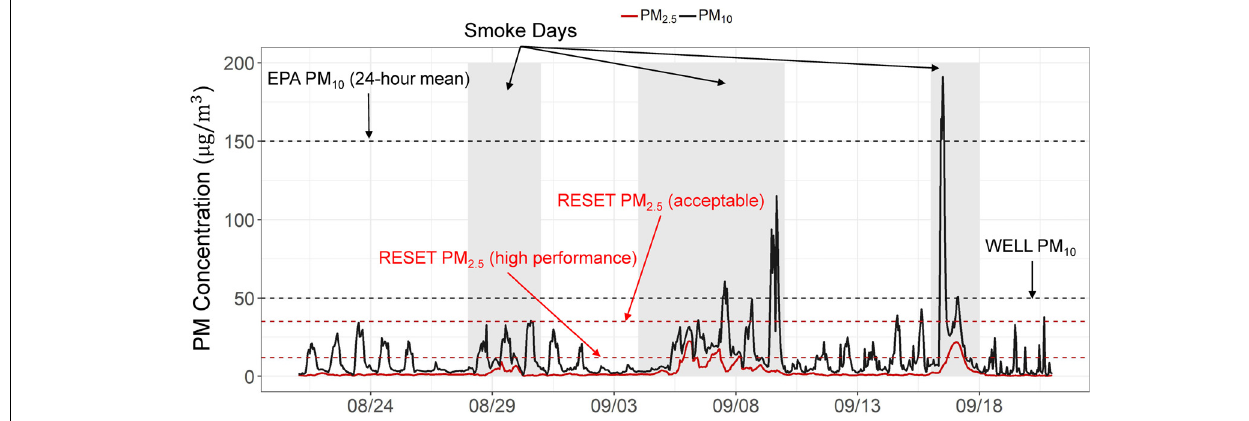
FIGURE 6 | Pre-retrofit PM 2 . 5 and PM 10 levels on C3.